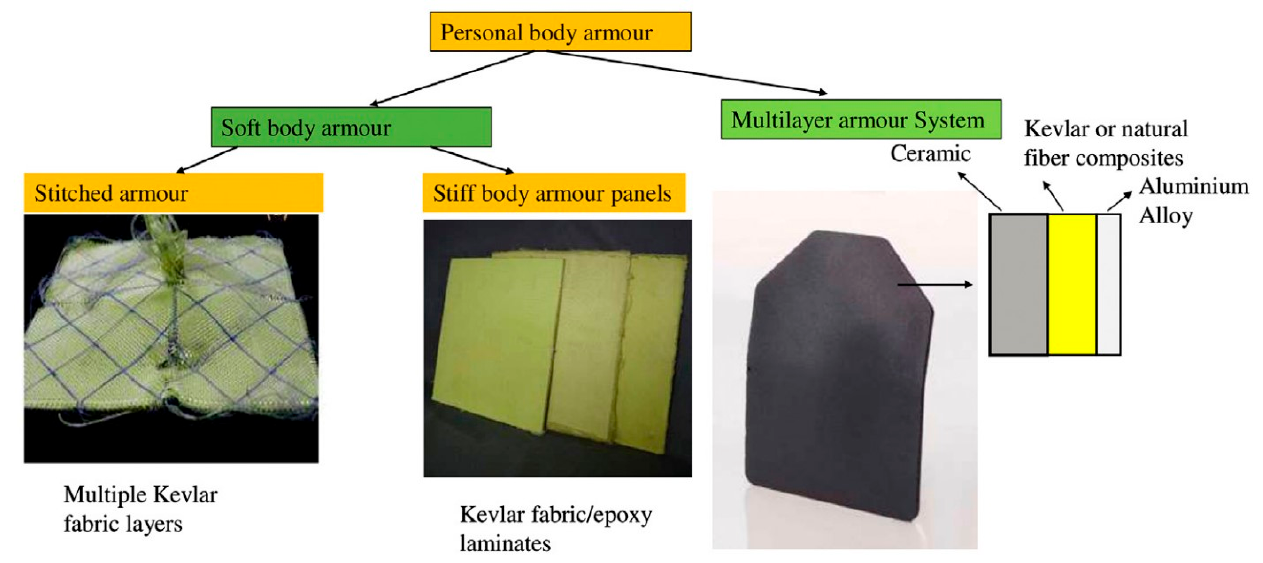
Figure 19. Different types and fabrication techniques for body armor.